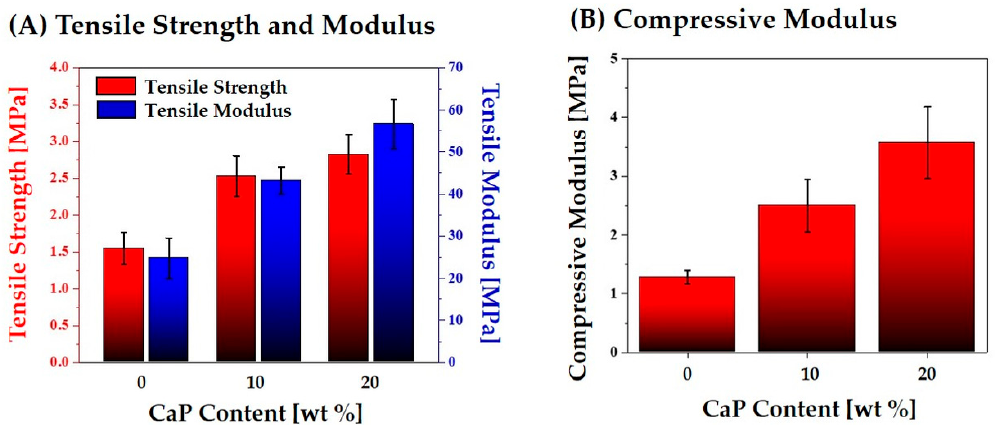
Figure 14. ( A ) Tensile strength and tensile modulus, and ( B ) compressive modulus of the hierarchical porous PCL–CaP composite scaffolds produced using various CaP contents (0, 10, and 20 wt%).